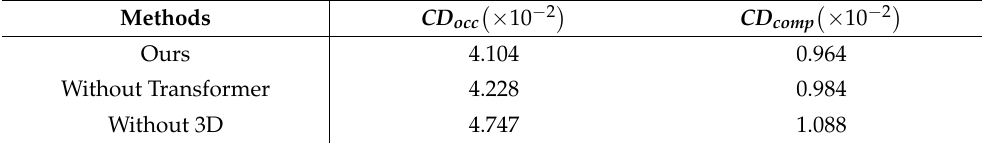
Table 2. Ablation study.